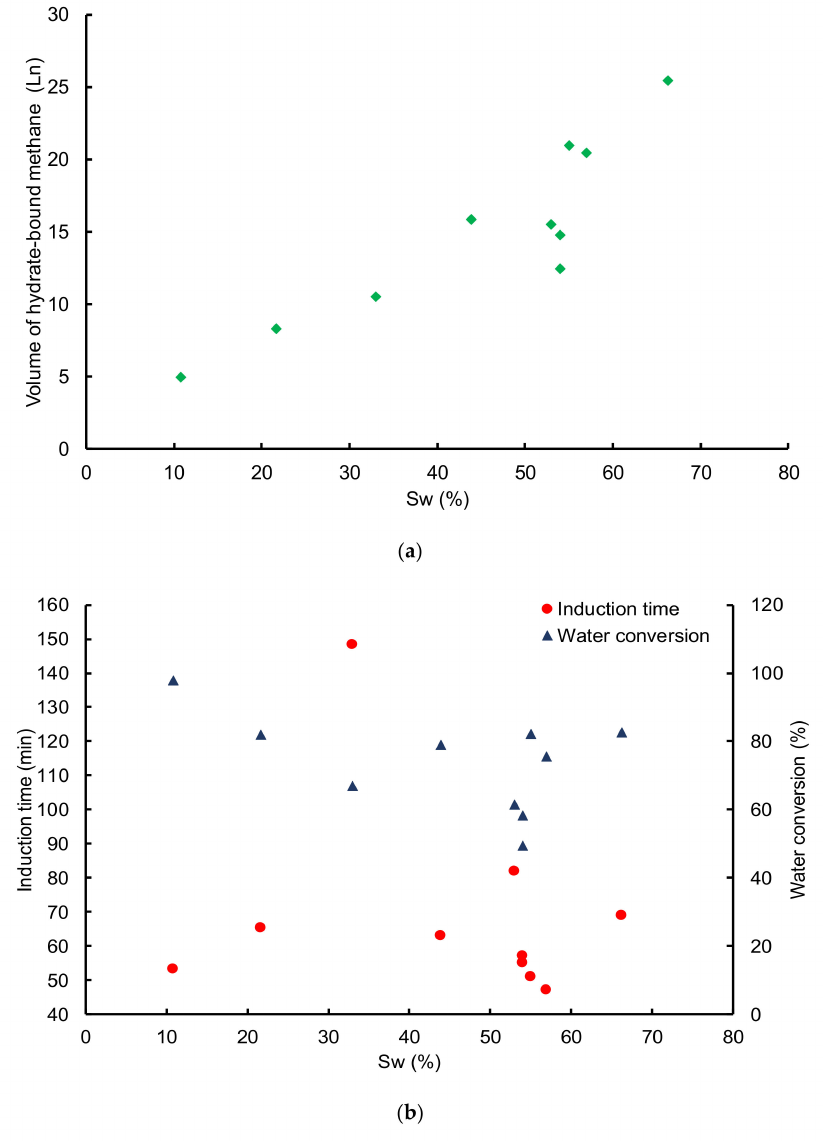
Figure 8. ( a ) Volume of hydrate-bound methane as a function of water saturation; ( b ) Induction time and water conversion as a function of water saturation. The experiments were carried out with a non-sieved sand sample and a gas flowrate around 58 mLn · min − 1